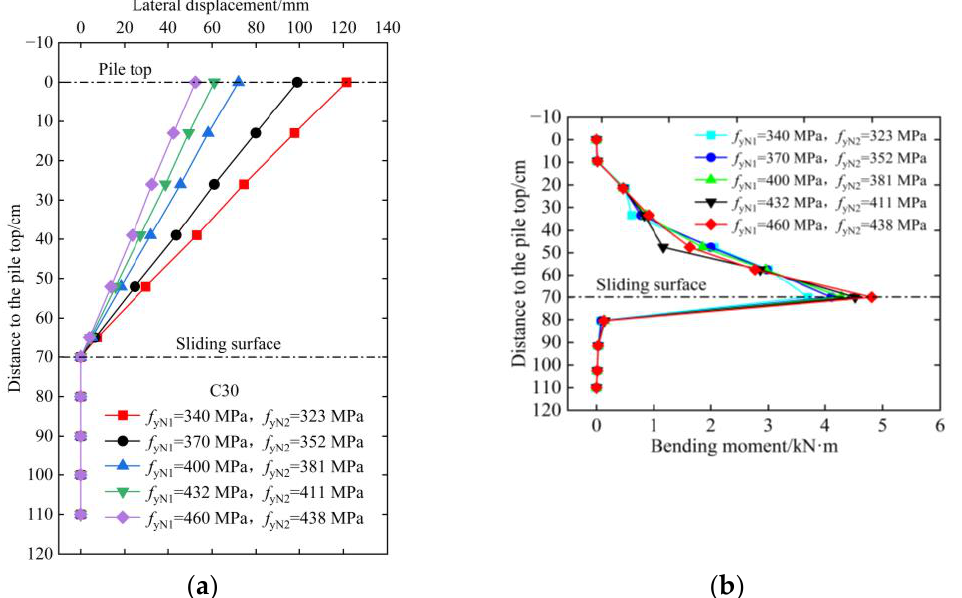
Figure 25. Variations of the pile displacement and bending moment with respect to steel bars’ strength. ( a ) Pile displacement; ( b ) pile bending moment.